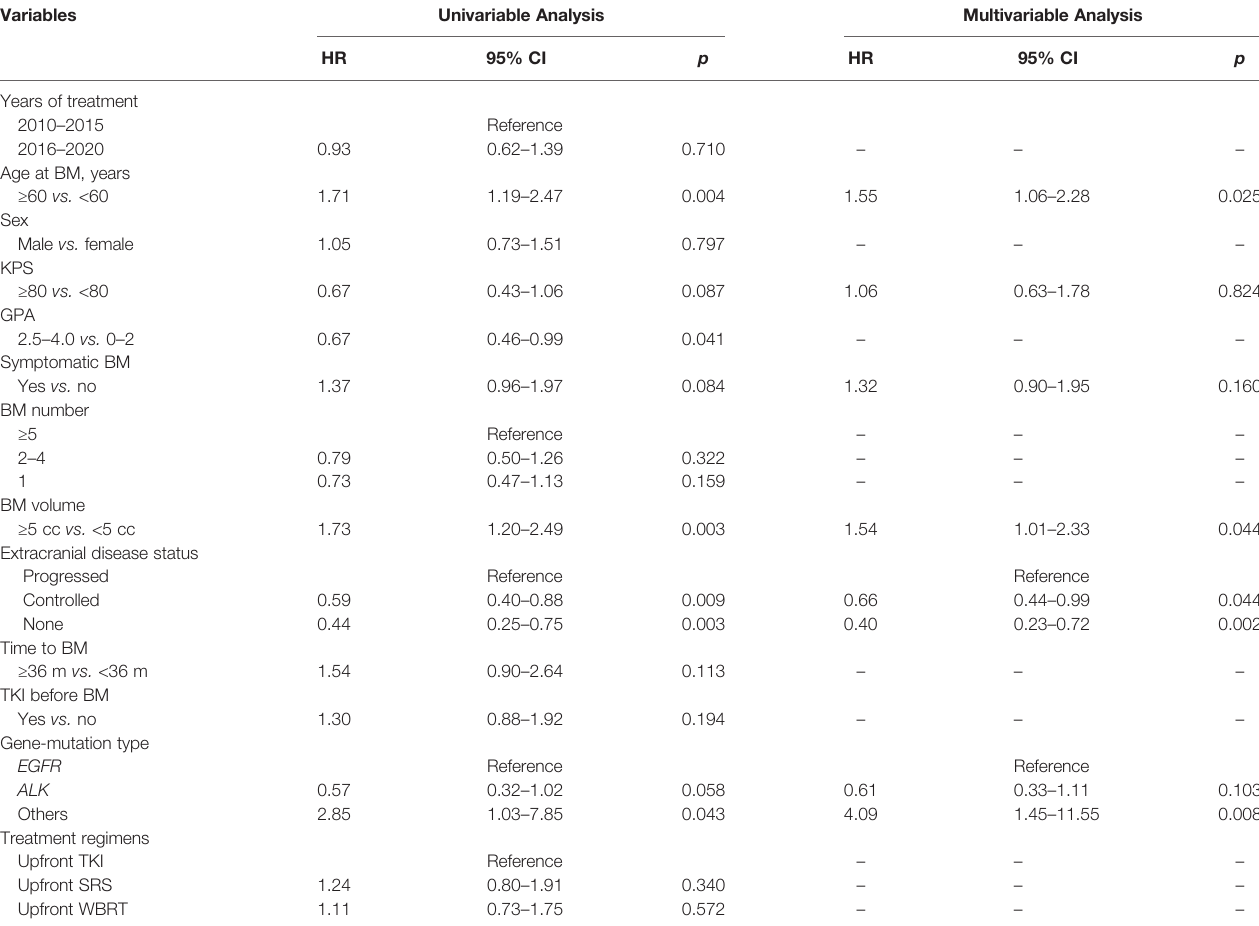
TABLE 3 | Univariable and multivariable analyses of variables associated with OS in the entire